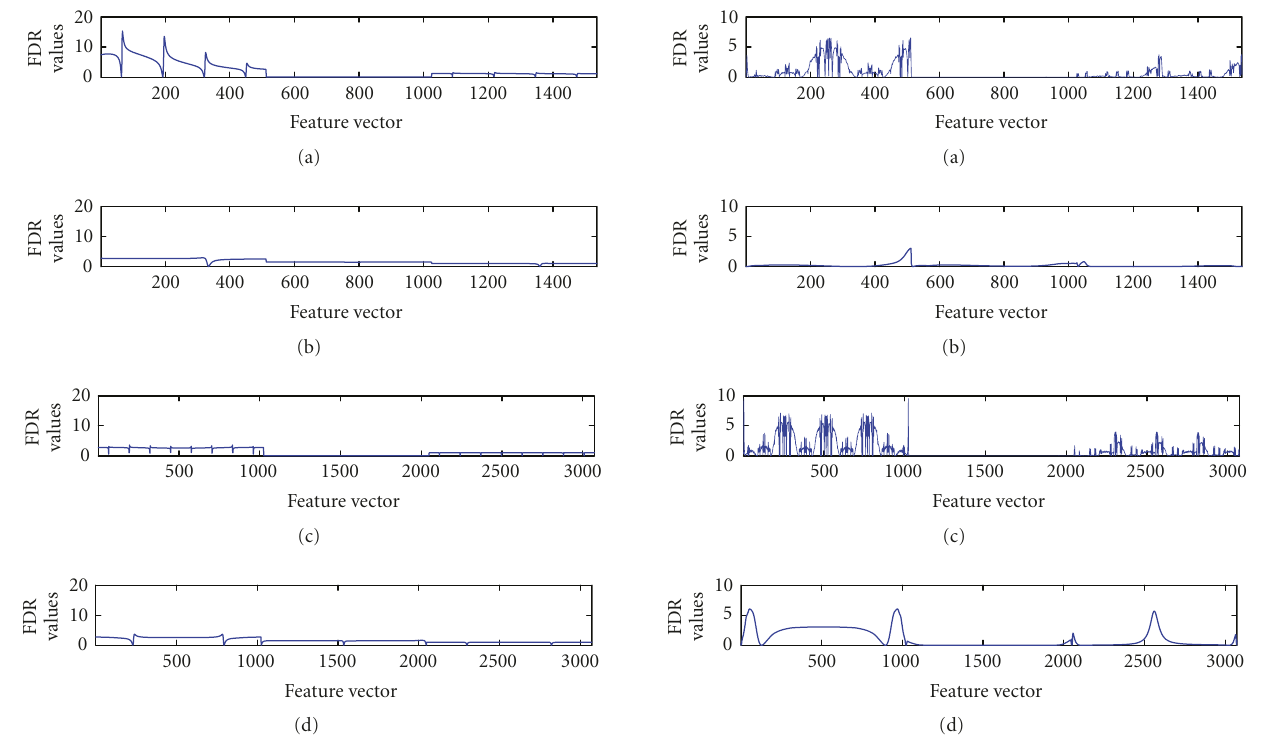
Figure 10: FDR values related to (a) (cid:9) c f , (b) (cid:9) c f feature vectors when the disturbance is interruption.